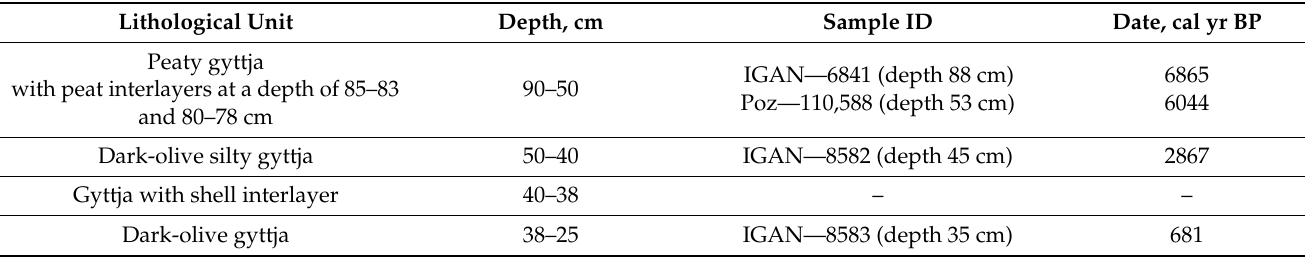
Table 1. Lithological and geochronological